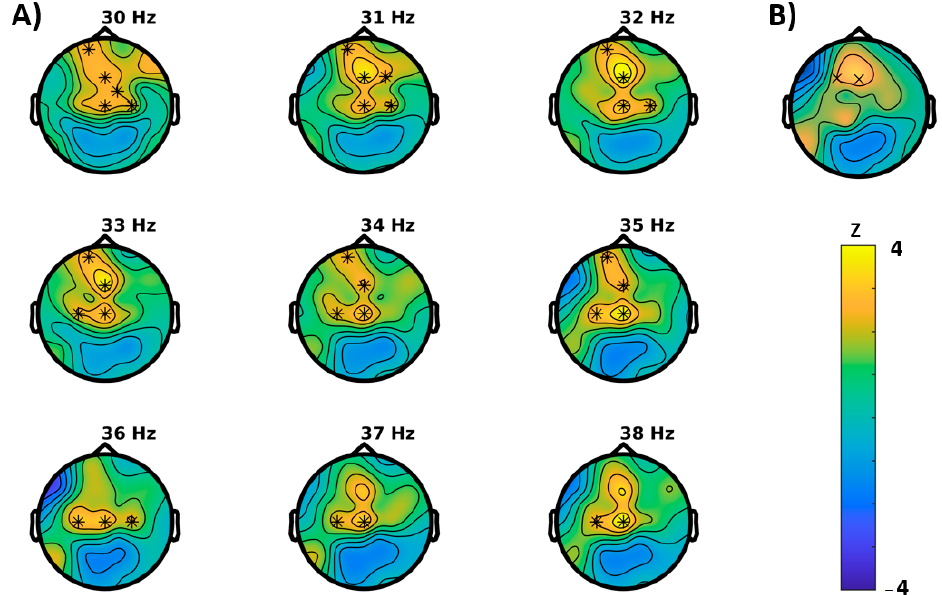
Figure 4. Results of the cluster based permutation tests for the congruent trials of the Simon task (BASELINE vs. MONTELUKAST, cluster corrected, x = p < 0.05, * = p < 0.01). ( A ) Cluster for spectral power and ( B ) Hjorth mobility.